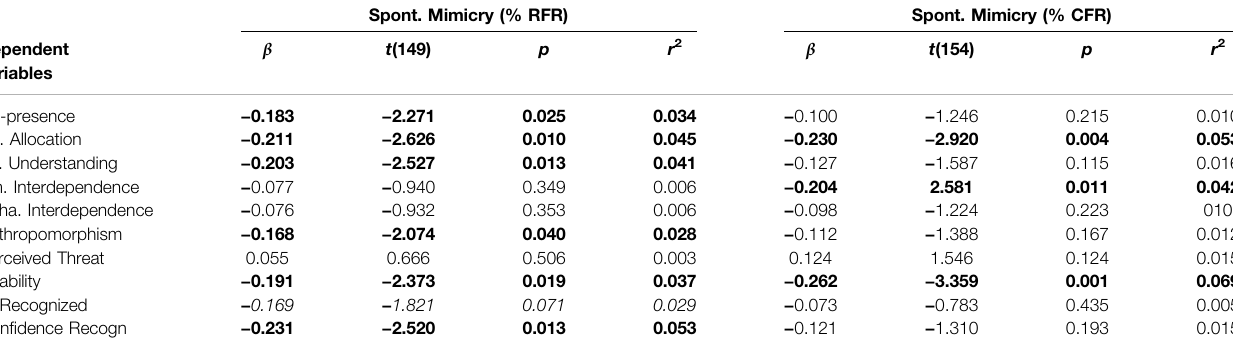
TABLE 6 | Regression Analyses [RQ3]. Frequency of spontaneous facial mimicry as predictor of Social Presence and Perceptions of Arti fi cial agents. The signi fi cant results are displayed in bold, while the trend effects are presented in italics. Spont. Mimicry (%